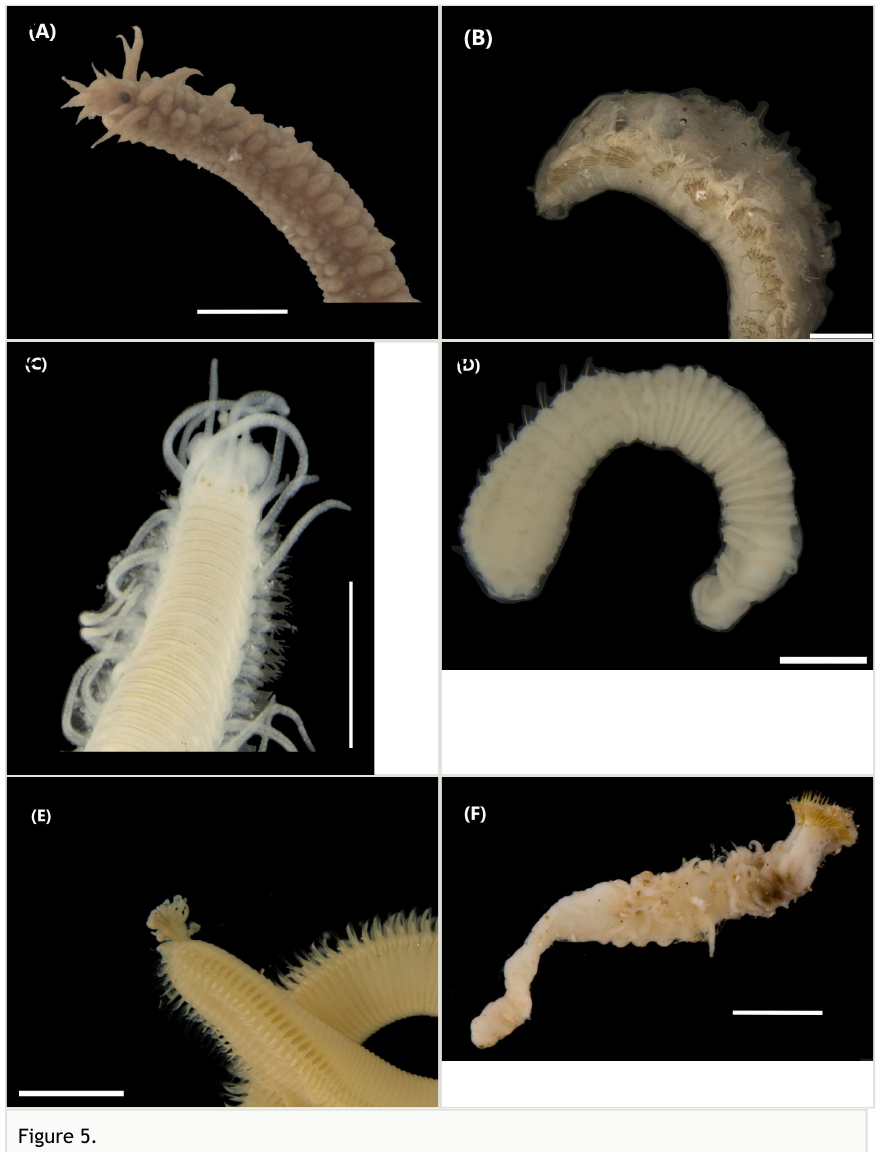
Figure 5. Annelids polychaetes identified on the beaches from Paraíba coast. Scale bars = 0.5 mm (A), 1 mm (B-D), 2 mm (E and F). Photos: (A-E) by Prata, J.; (F) by Freitas,